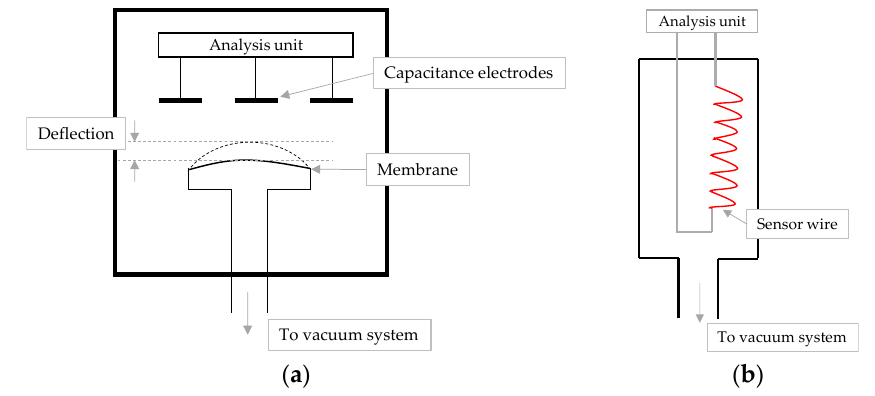
Figure 3. Schematic design of ( a ) capacitance sensor and ( b ) Pirani sensor.